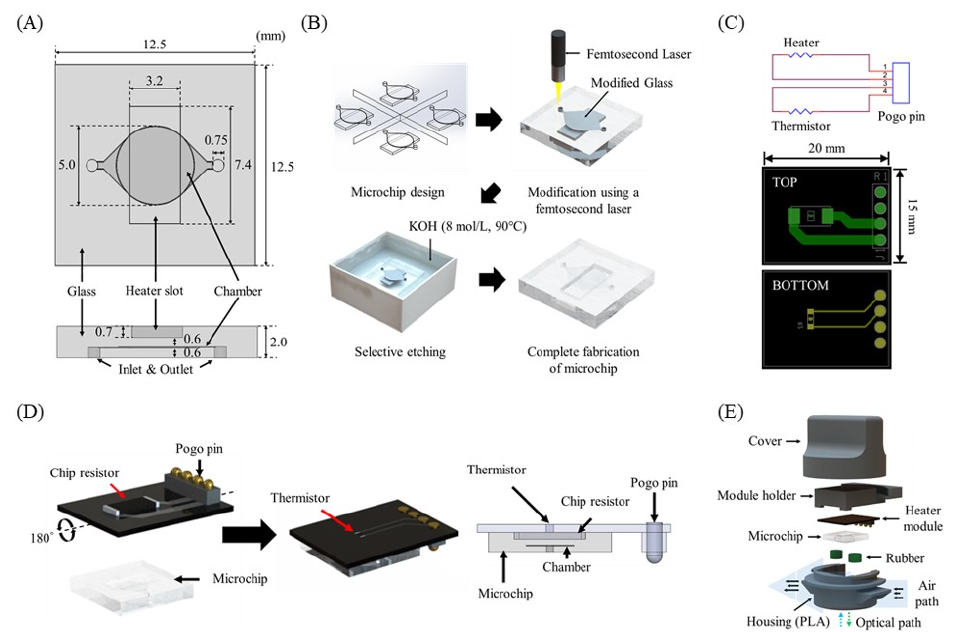
Figure 4. ( A ) PCR microchip. ( B ) Microchip fabrication steps using the SLE process. ( C ) Heater module circuit and PCB design. ( D ) Schematic of the heater module including a chip resistor heater and a thermistor, and the integrated heater module with the microchip. ( E ) Components of the thermocycler